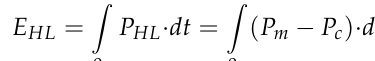
Figure 7. Energy consumption of constant components within an hour.